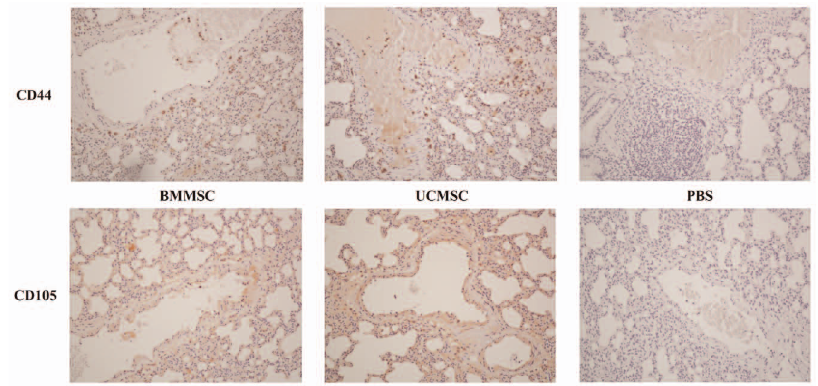
Figure 6. Evaluation of lung immunohistochemistry in rats 18 hours after CLP. Positive cells for CD44 or CD105 which represented the transferred human MSCs can be found in the perivascular interstitial area 14 hours after administration of BMMSCs or UCMSCs (200 6 ).